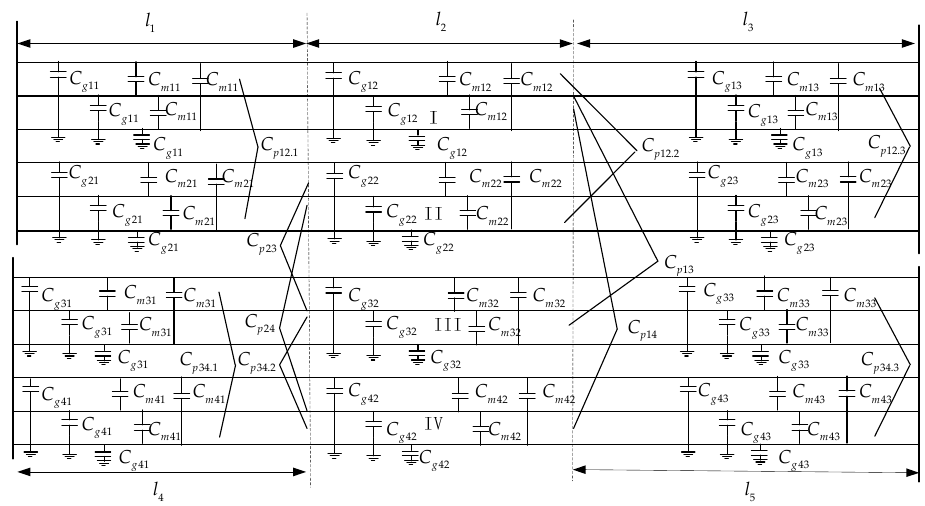
Figure 2. Capacitance distribution of the complex four-circuit lines on the same tower.